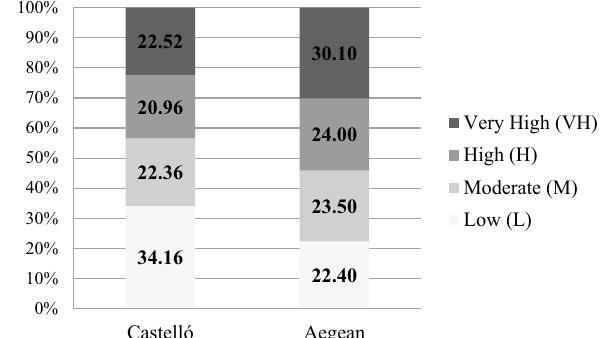
Figure 1. Distribution of the respondents by the vulnerability